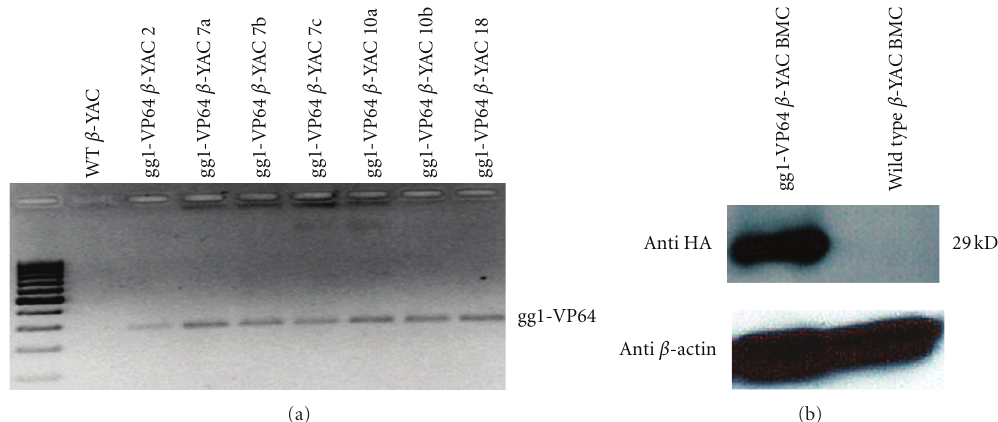
Figure 1: Expression of gg1-VP64. (a) Total RNA isolated from gg1-VP64 β -YAC bigenic line adult peripheral blood was analyzed by RT- PCR using gg1-VP64-specific primers. Each lane shows an individual from the established lines; numbers are indicated at the top of the panel; the gg1-VP64 product is indicated to the right side of the panel. (b) Cellular lysates from CID-dependent gg1-VP64 β -YAC BMCs were assayed by western blotting using an anti-HA tag antibody to detect the gg1-VP64-HA fusion (29kDa, indicated to the right of the panel). CID-dependent β -YAC BMCs were used as the negative control. Anti- β -actin was employed as loading control. M, marker lane.